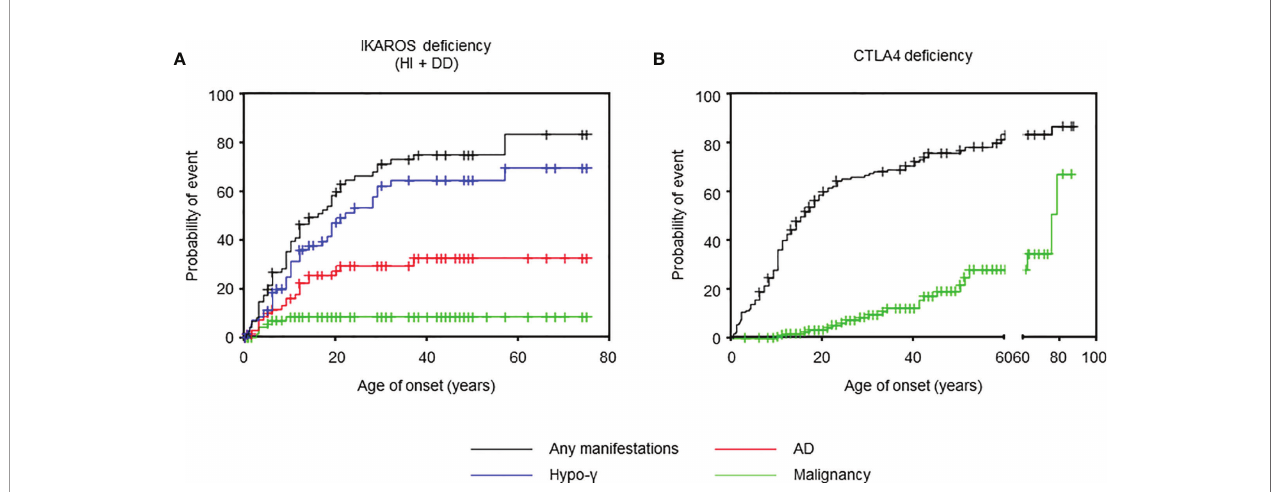
FIGURE 1 | Age of onset in IKAROS and CTLA4 de fi ciencies. (A) Cumulative incidence of any manifestations (n = 77), hypogammaglobulinemia (n = 73), autoimmune disease (n = 72), and malignancy (n = 75) in IKAROS HI and IKAROS DD. (B) Cumulative incidence of any manifestation (n = 158) and malignancy (n = 166) in CTLA4 de fi ciency. AD, autoimmune disease; hypo- g ,